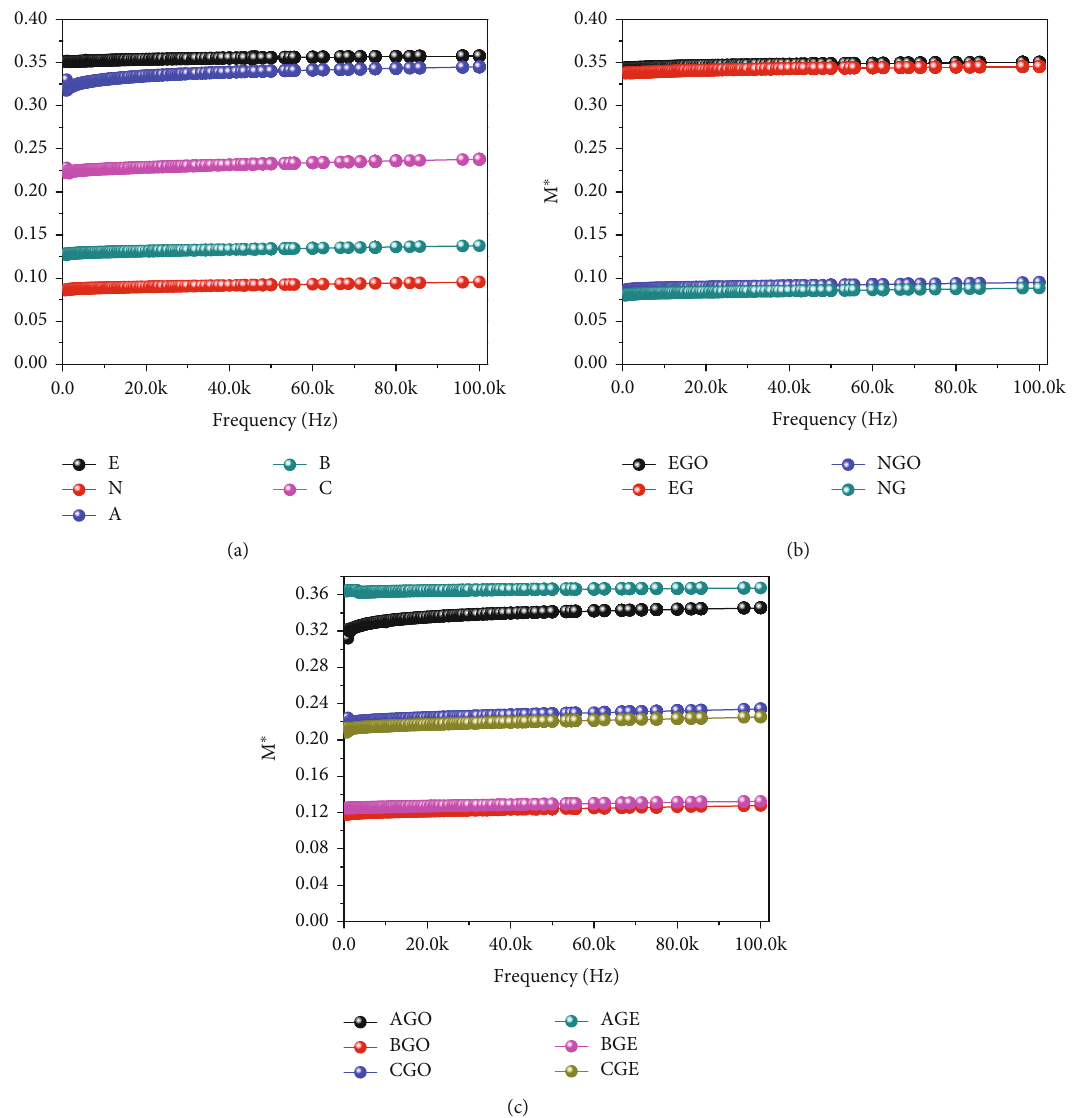
Figure 11: Dielectric modulus of (a) un fi lled single and double matrix, (b) single matrix- fi lled GO and G, and (c) double matrix- fi lled GO and